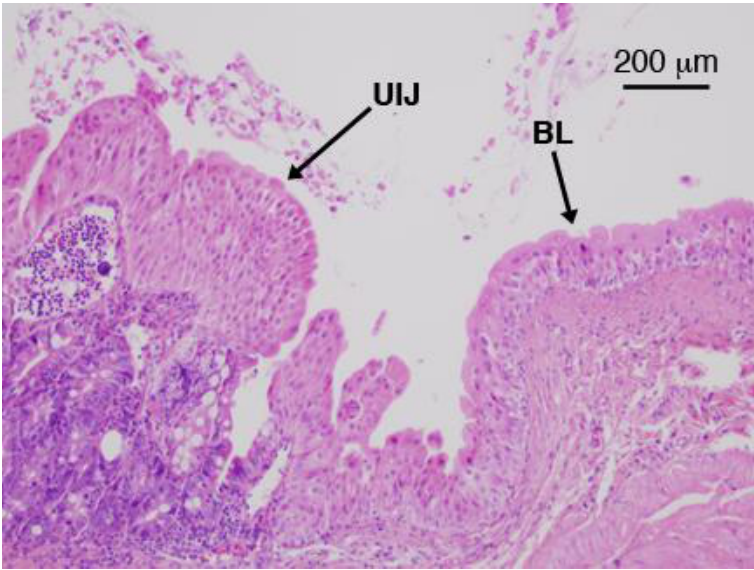
FIGURE 1. H&E-stained section of the ICP bladder demonstrating thickening of the urothelium overlying the bowel mucosa at the urointestinal junction (UIJ) relative to bladder